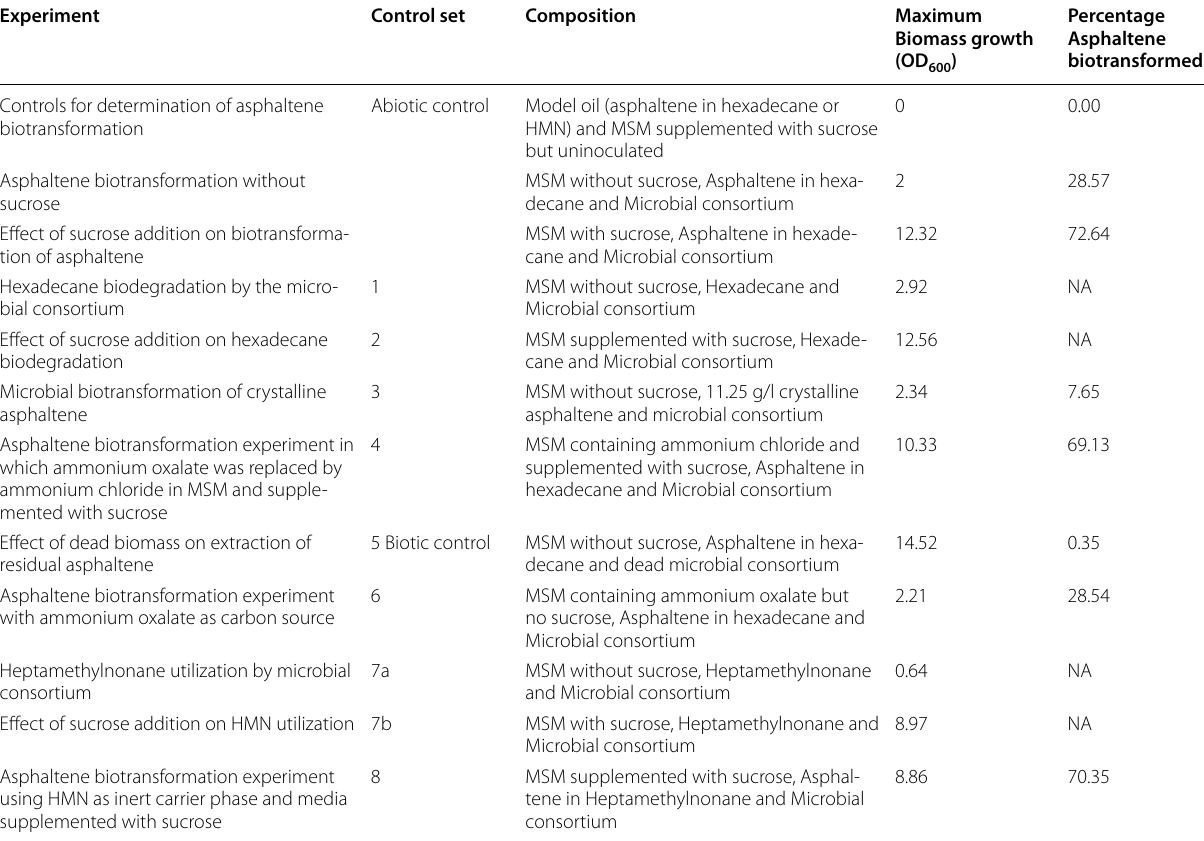
Table 2 Control experiments for asphaltene biotransformation